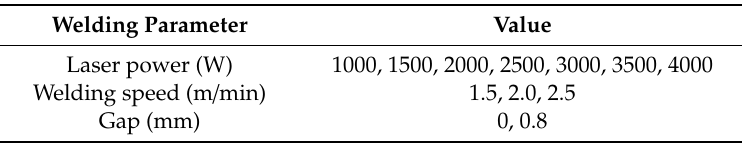
Table 1. Experimental factors and their values.